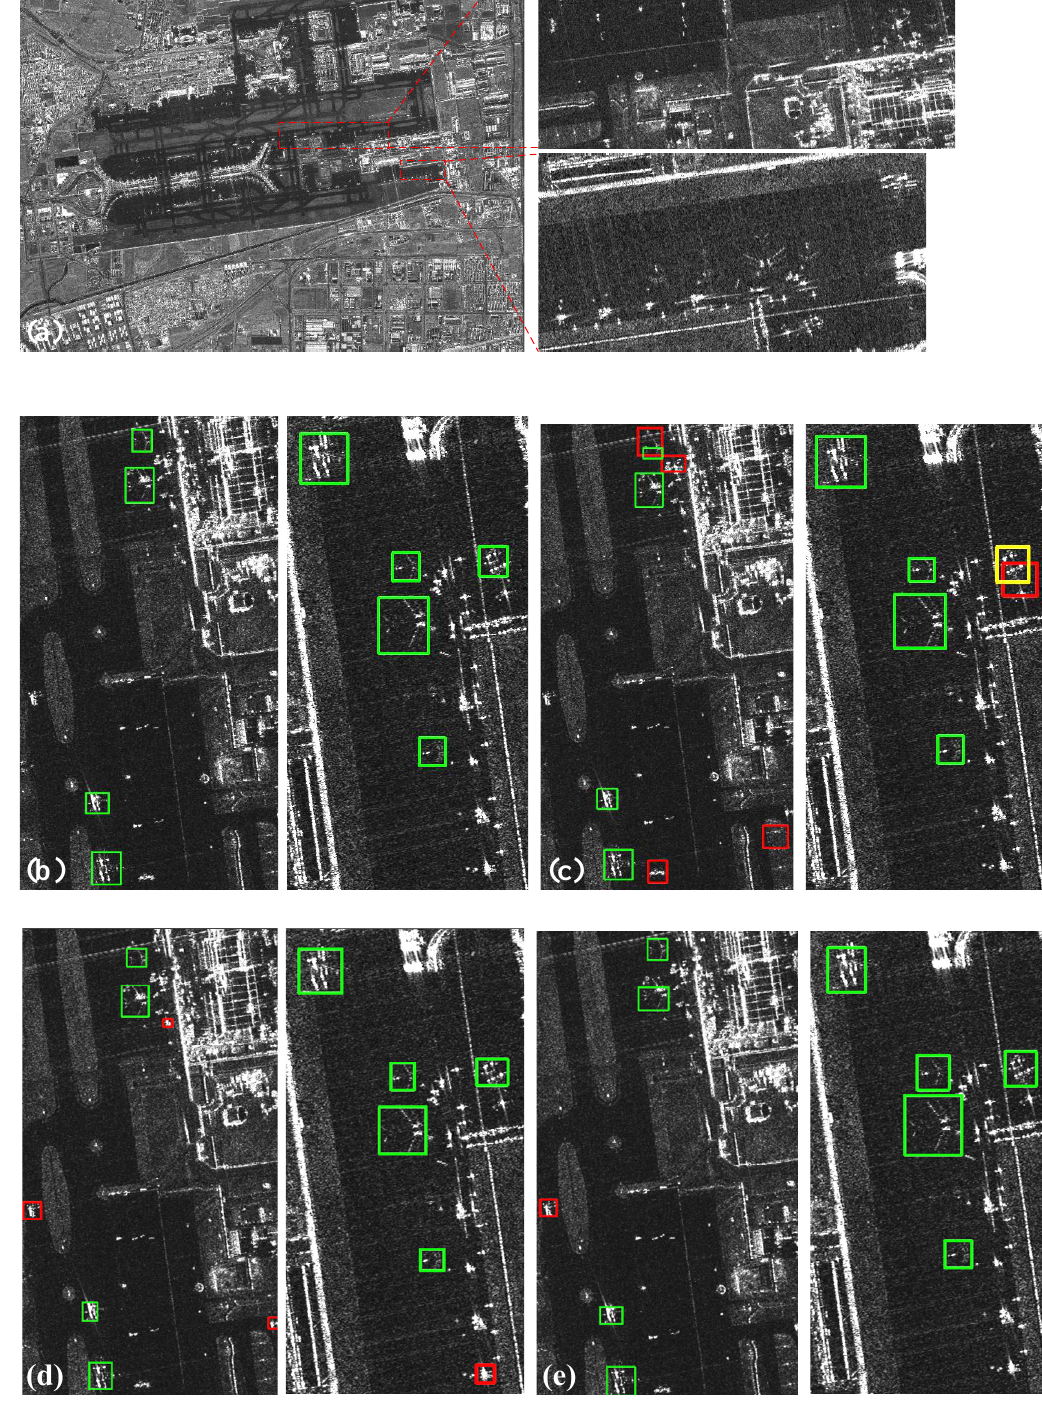
Figure 13. The experiment result for Airport I. ( a ) SAR image of Airport I from Gaofen-3. ( b ) The ground truth of the airport. ( c – e ) the aircraft detection results of ( a ) by EfficientDet, YOLOv4, and EWFAN. The green box, the red box, and the yellow box represent the correctly detected aircrafts, the false alarms, and the missed alarms respectively.